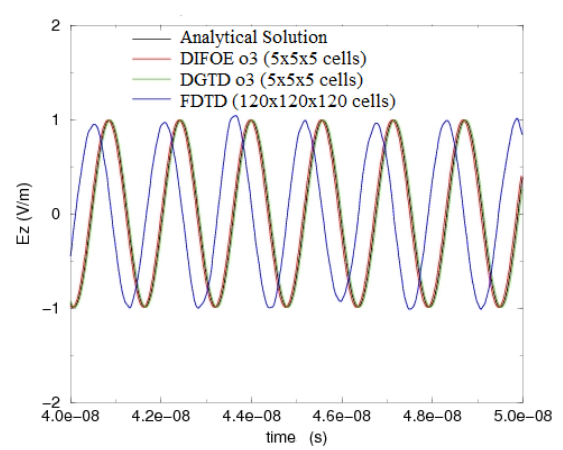
Figure 3: Comparisons between a DG scheme and our method with same mesh and spatial